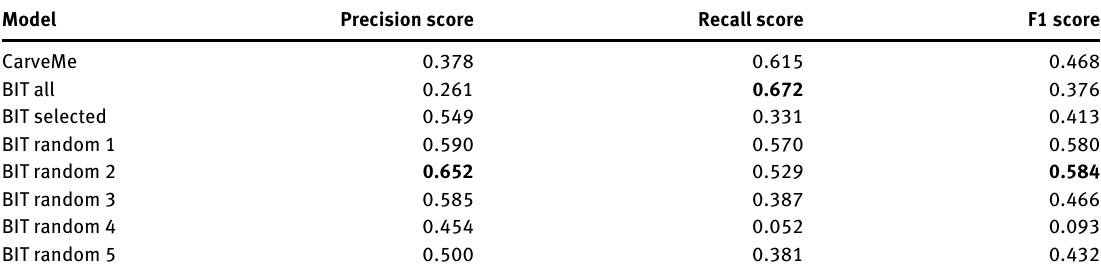
Table 3: Comparison of the evaluation metrics between draft models generated with CarveMe and with BIT for X. fastidiosa . Model Precision score Recall score F1 score CarveMe